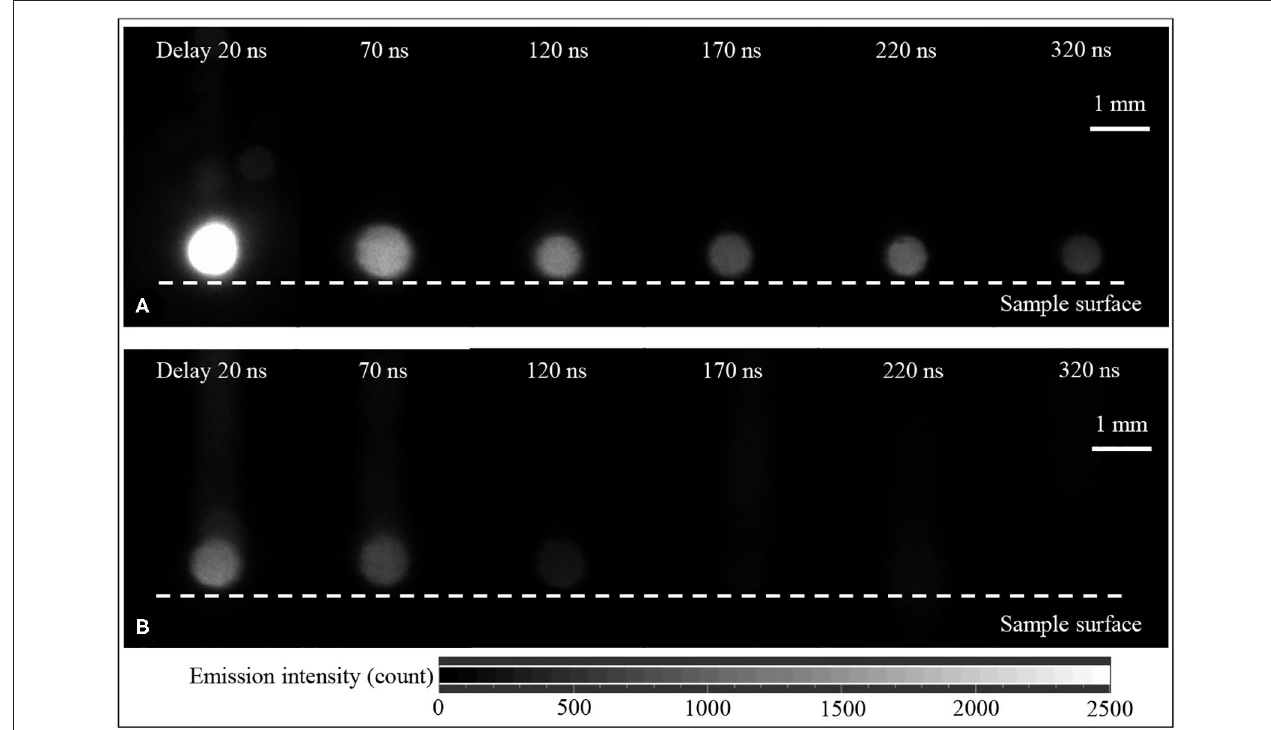
FIGURE 5 | Plasma images of underwater LIBS measurement. (A) Collinear LS-DP-LIBS and (B) conventional SP-LIBS. Experimental conditions: gate width: 100 ns, accumulation: 1 shot.